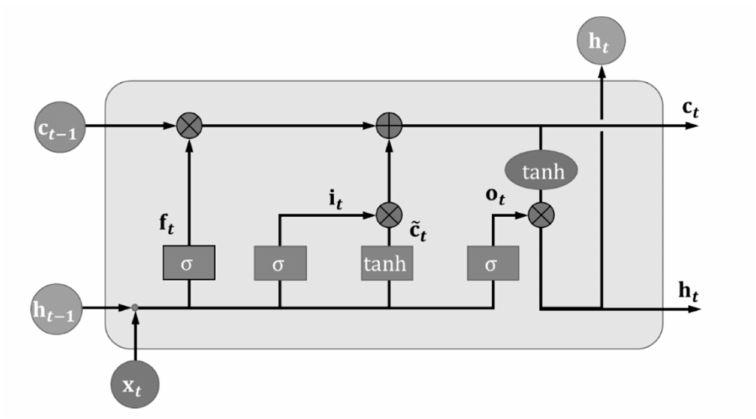
Figure 1. Visualization of a Long Short-Term Memory (LSTM)